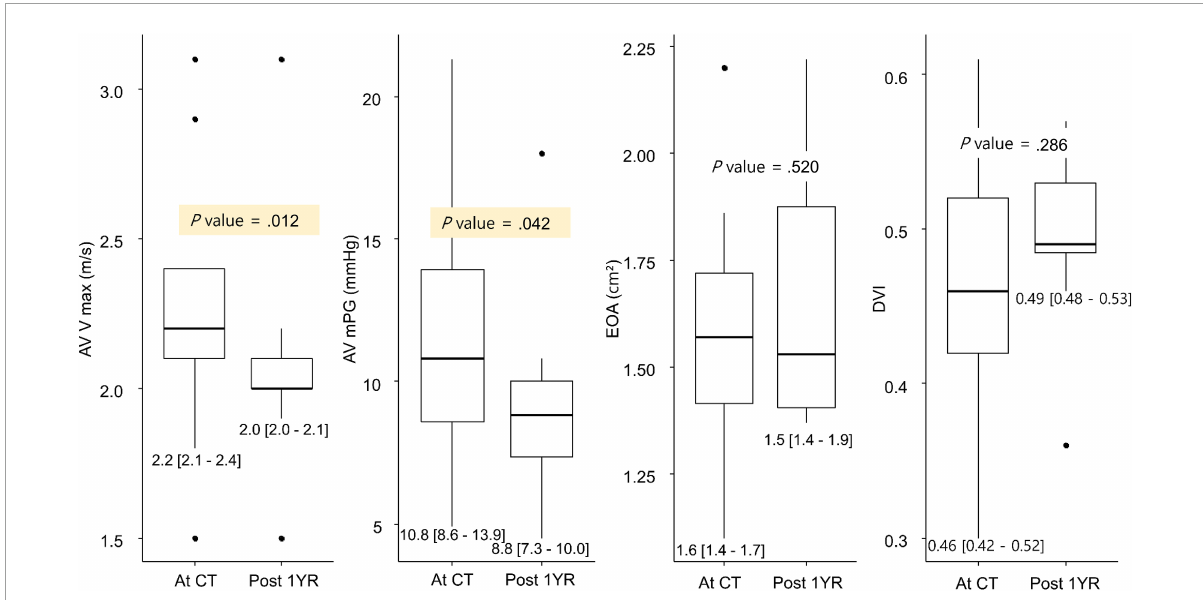
FIGURE4 Change in AV hemodynamics on the 1-year follow-up MDCT. AV, aortic valve; DVI, Doppler velocity index; EOA, estimated orifice area; MDCT, multidetector computed tomography; mPG, mean pressure gradient; Vmax, peak aortic valve